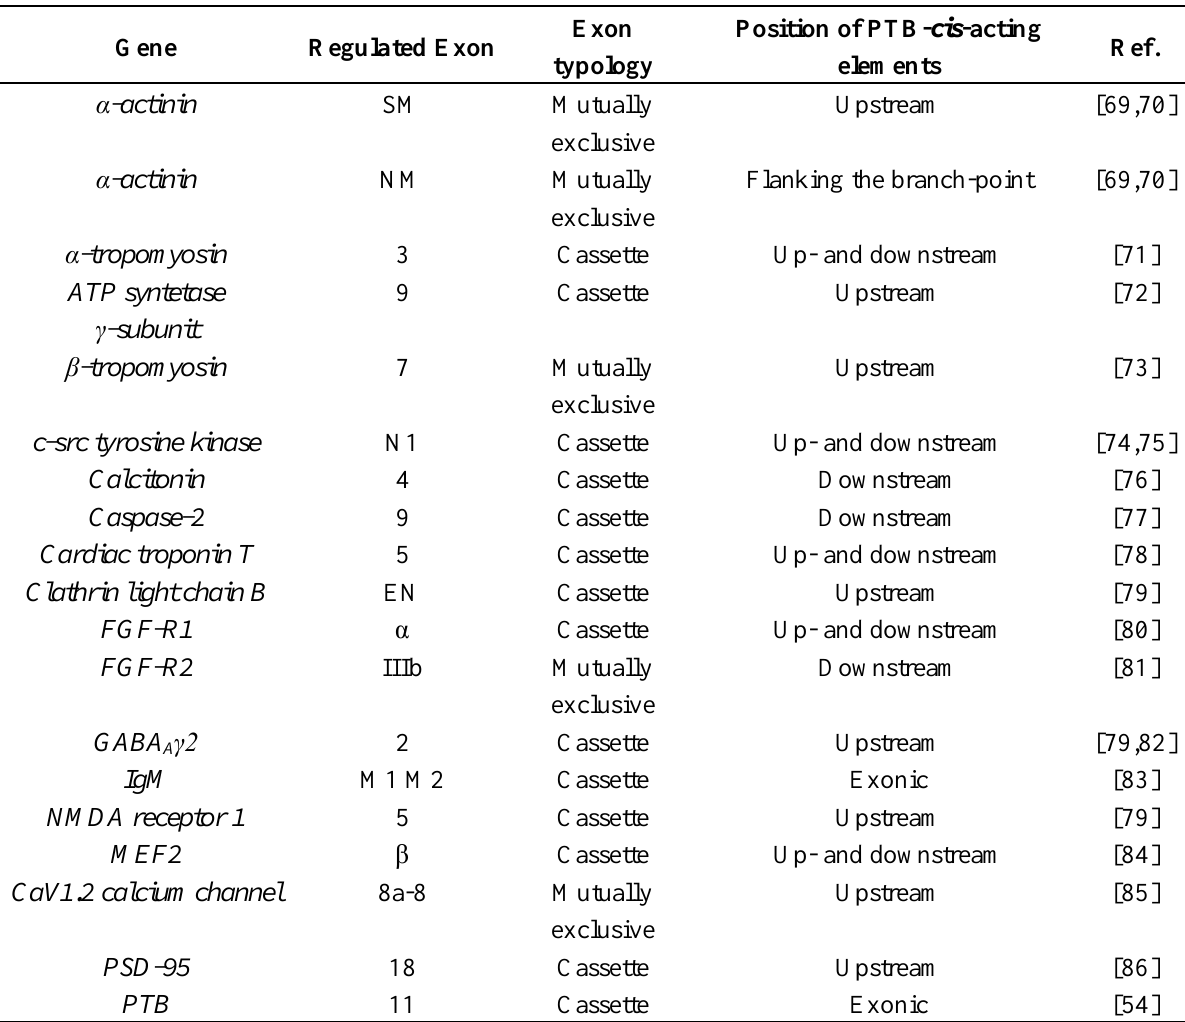
Table 1. Exons regulated by